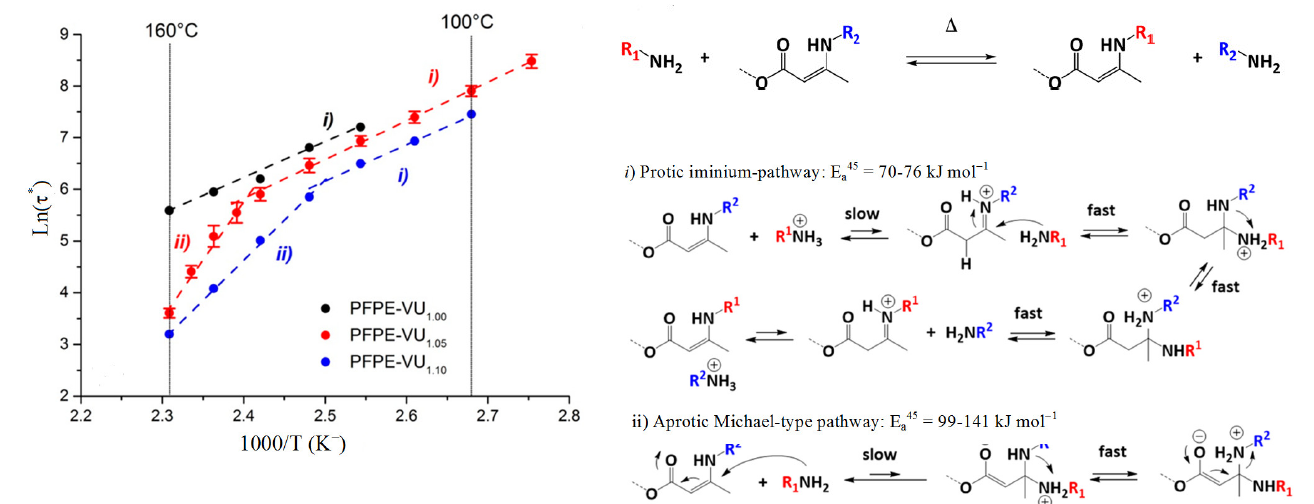
Figure 8. Vinyl urethane vitrimers exhibiting a dual temperature reaction based on two concomi- tant exchange mechanisms: the iminium type in the lower temperature range with an energy bar- rier of E a 60–70 kJ/mol and the Michael reaction type at higher temperatures with a higher E a of 130–170 kJ/ mol. Reprinted with permission from [117]. Copyright (2018) American Chemical So-